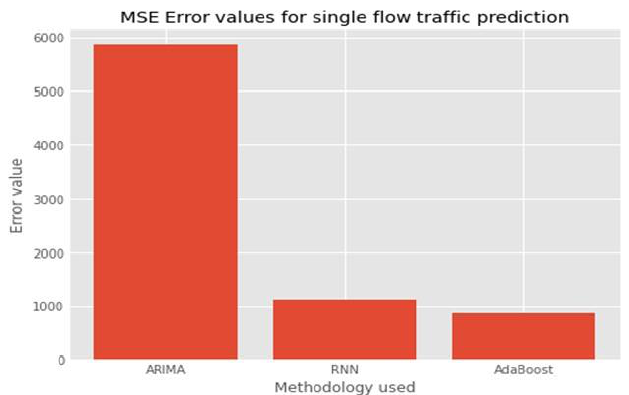
Figure 16. Comparing the MSE between RNN, ARIMA, and AdaBoost for single flow Performance evaluation of RNN, ARIMA and AdaBoost models for relative error values when 300 samples are used for training: This section is similar with the previous section, but it takes